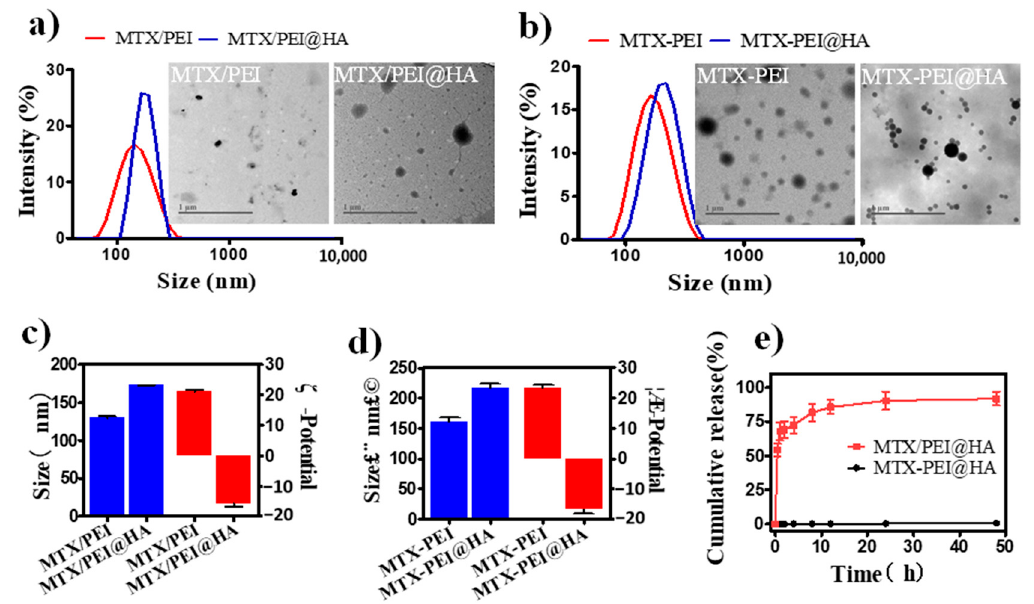
Figure 2. Physicochemical characteristics of MTX NPs. Physicochemical characterization of MTX/PEI NPs ( a ) and MTX-PEI NPs ( b ) with or without HA coating by using transmission electron microscopy and DLS. Scale bar = 1 µ m. ( c , d ) Zeta potential and size analysis of MTX/PEI, MTX/PEI@HA, MTX-PEI and MTX-PEI@HA NPs in ultrapure water. ( e ) In vitro release kinetics of MTX from MTX/PEI@HA NPs and MTX-PEI@HA NPs. All data represent means ± S.D. of three